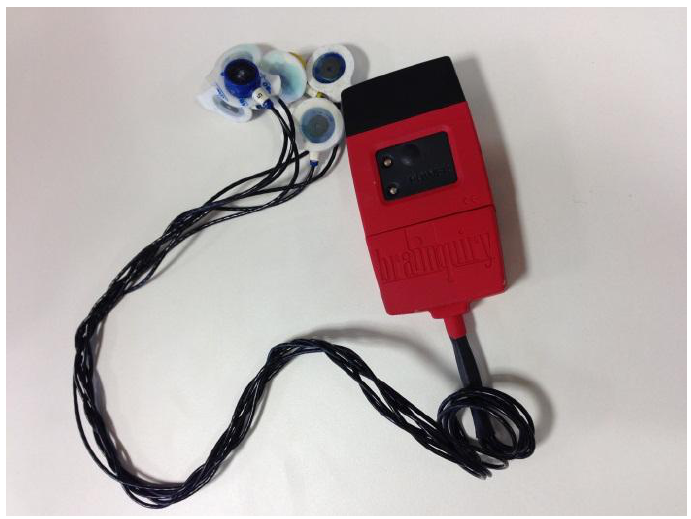
Figure 10. Brainquiry Wireless EMG/EEG/ECG